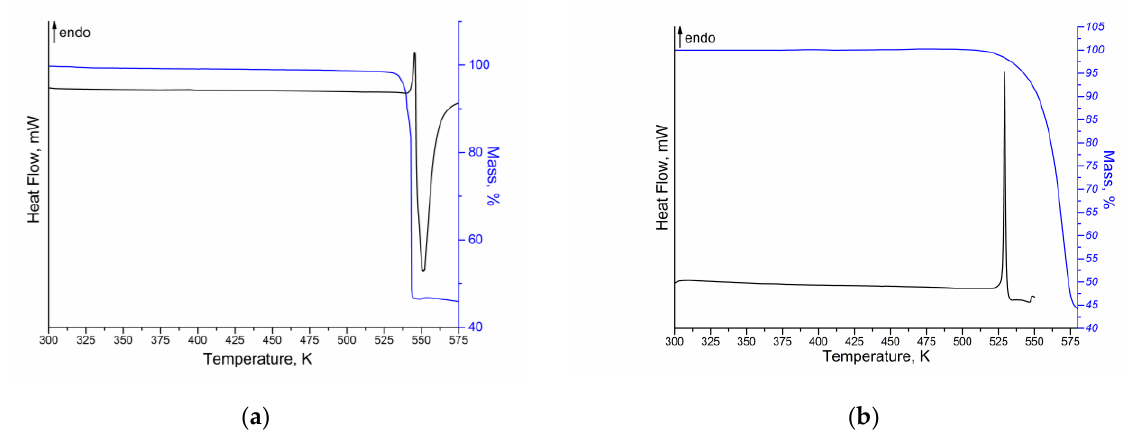
Figure 4. DSC (black) and TG (blue) curves of ( a ) NFT and ( b ) FZL. According to the DSC/TG curves obtained, NFT and FZL are stable up to the start of the sample melting. In both cases, some overlapped endothermic and exothermic events are observed in the range of 530–575 K for NFT and 520–550 K for FZL, that are related to the melting of API (endo-effect) and its degradation (exo-effect). Therefore, it is not possible to calculate the enthalpy of fusion of the compounds. For NFT, a single endotherm at T onset = 541.2 ± 0.2 K ( T peak = 543.0 ± 0.2 K) is found to correspond to the API fus fus